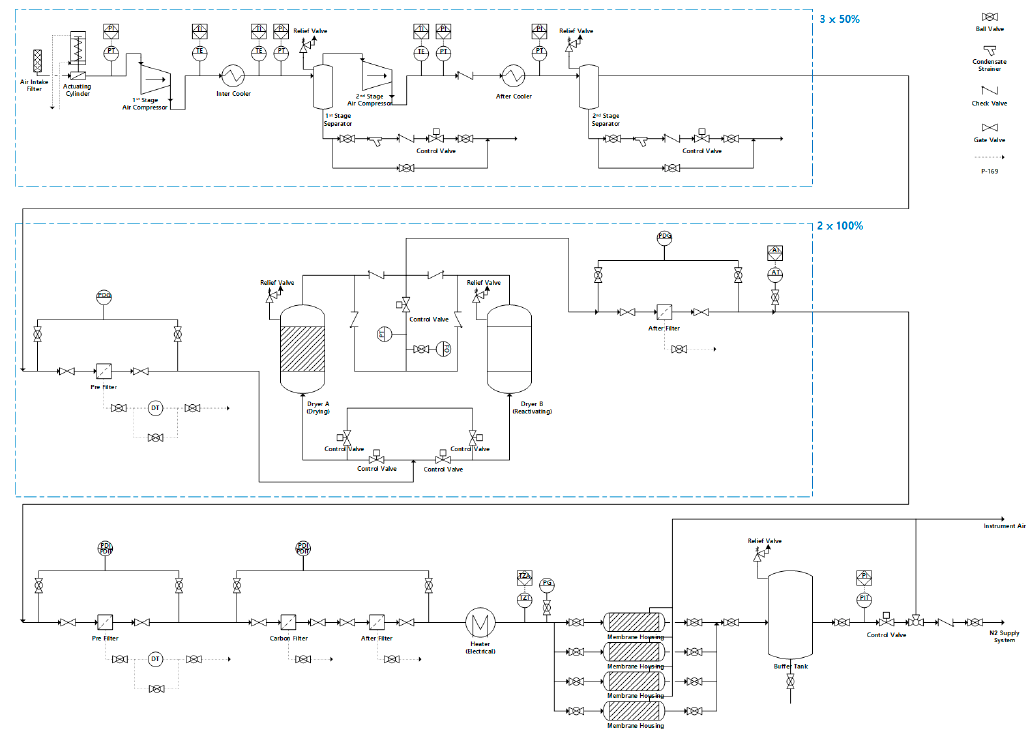
Figure 4. The preliminary process and instrument diagram (P&ID) of air and nitrogen system.